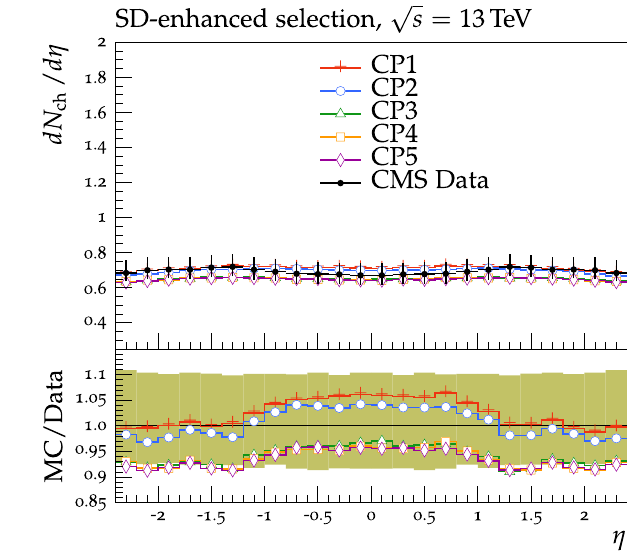
Fig. 13 The pseudorapidity distribution ( p T > 0 . 5GeV, | η | < 2 . 4) for the NSD-enhanced (left) and the SD-enhanced (right) event selec- tion of charged particles in inelastic proton-proton collisions, from the √ s = 13TeV analysis [24]. The data are compared with the CMS CMS pythia 8 LO-PDF tunes CP1 and CP2, the CMS pythia 8 NLO-PDF tune CP3, and the CMS pythia 8 NNLO-PDF tunes CP4 and CP5. The